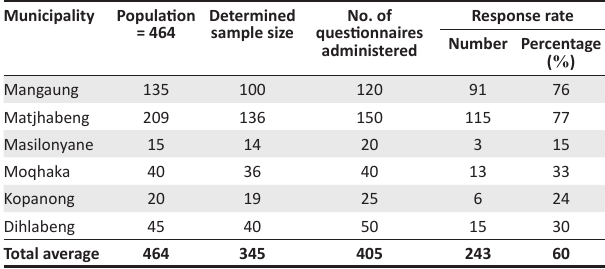
TABLE 1: Response rate for each municipality.